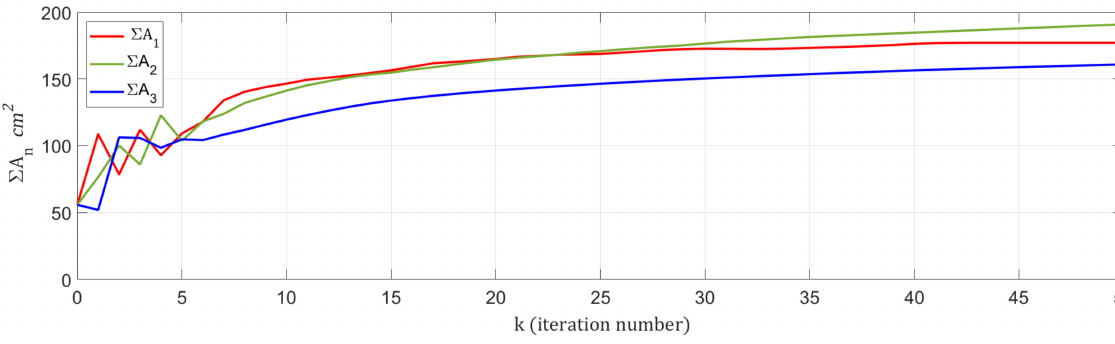
Figure 7. Fixed-point iterative process for the three-story rigid frame